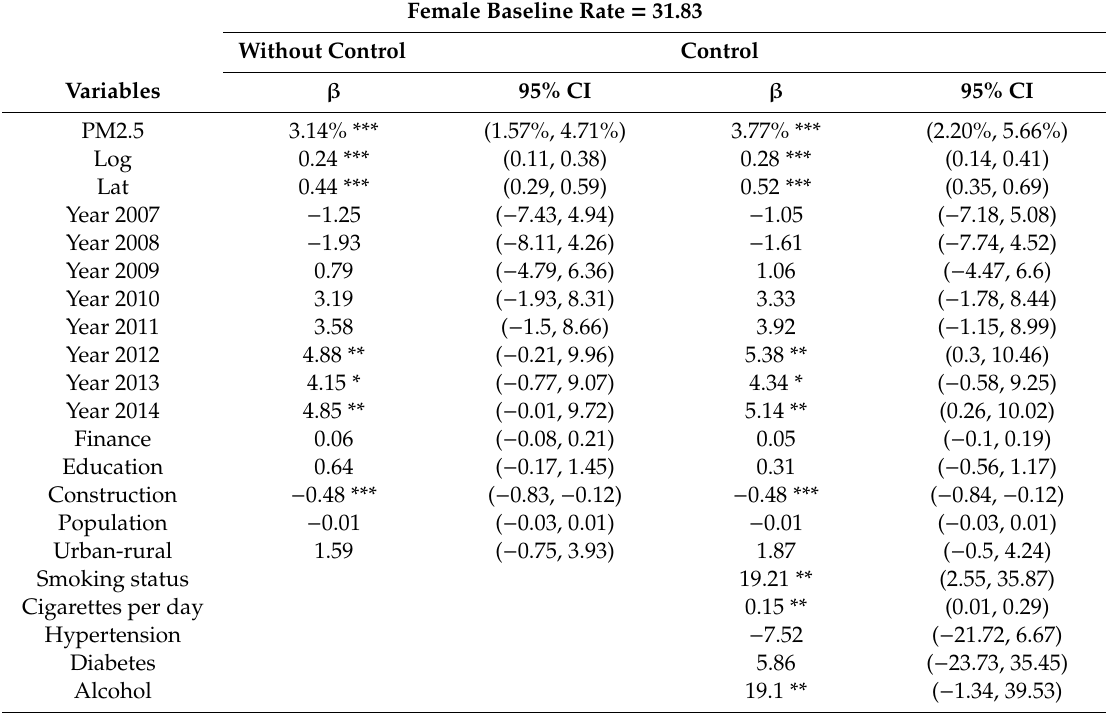
Table 5. Sensitivity analysis of PM2.5 e ff ect adjusted by health and behaviour covariates for females. Female Baseline Rate =